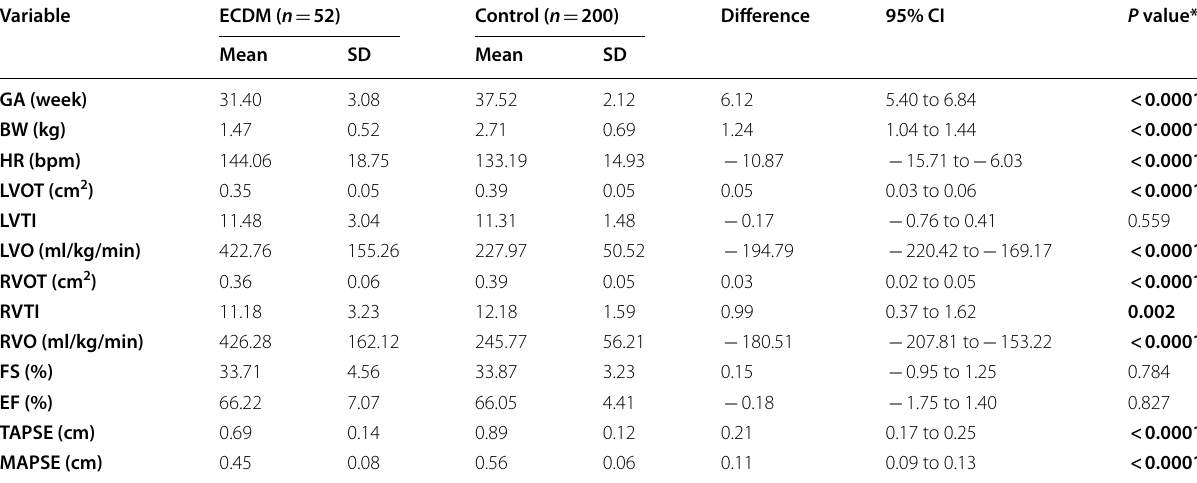
GA gestational age, BW birth weight, HR heart rate, LVOT left ventricular outflow tract diameter, LVTI left flow tract velocity time integral, LVO left ventricular output, RVOT right ventricular outflow tract diameter, RVTI right flow tract velocity time integral, RVO right ventricular output, FS fractional shortening, EF ejection fraction, TAPSE tricuspid annular plane systolic excursion, MAPSE mitral annular plane systolic excursion Data are the mean and standard deviation